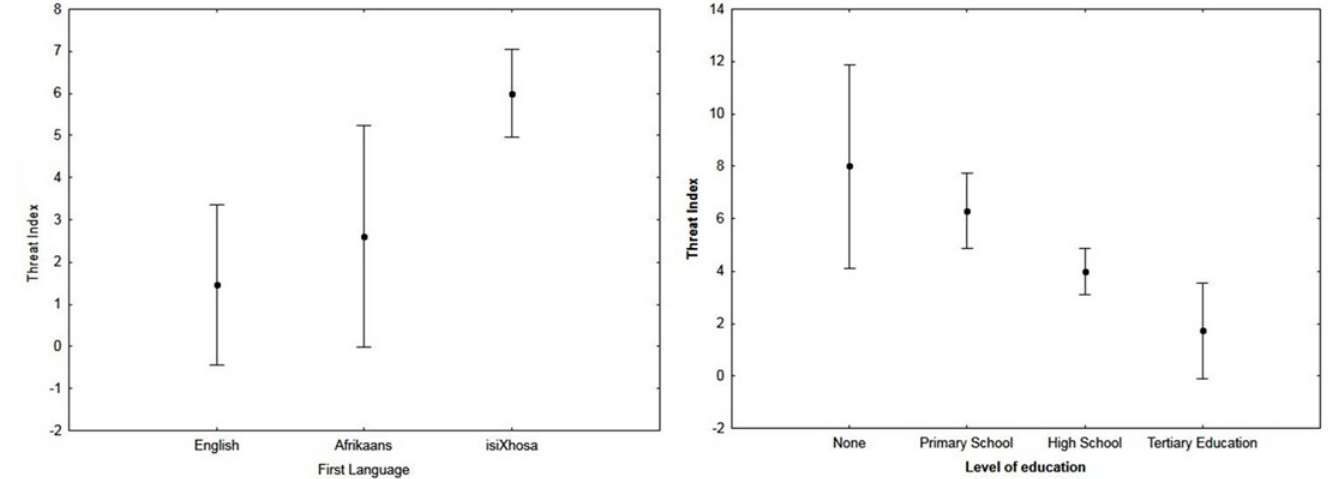
Fig 4. The significant relationships between the first language of a respondent and their threat index (F (2; 118) = 13.87; p < 0.05) and the level of education of respondent and threat index (F (3; 123) = 3.53; p <